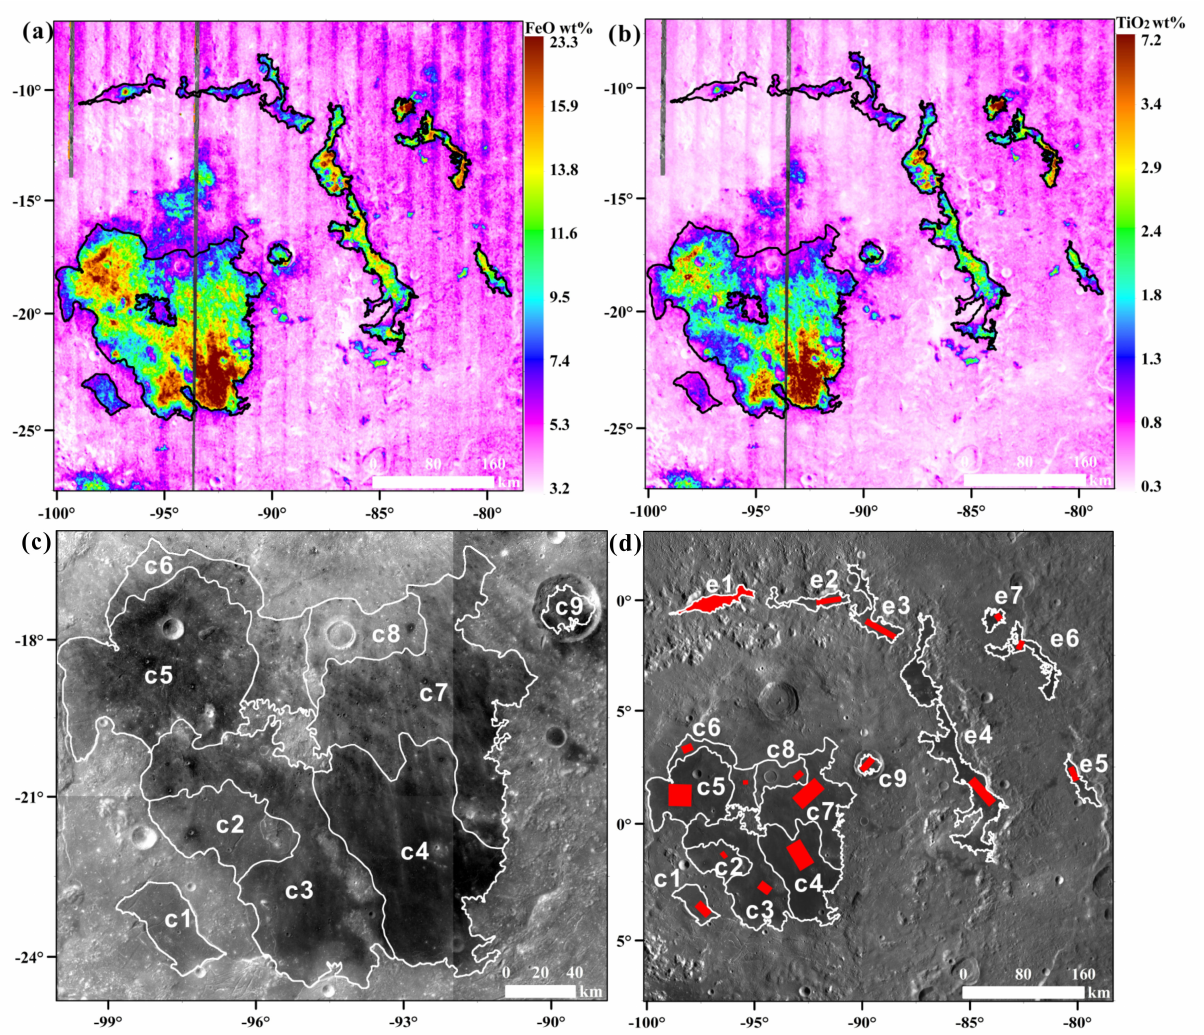
Figure 4. ( a ) IIM FeO abundance (wt%) map of the study area; ( b ) IIM TiO 2 abundance (wt%) map of the study area; ( c ) Newly defined geologic (basalt) units of the Orientale Basin. White lines denote the central basalts. As the background image is spliced from 7 CE-2 CCD images, there is a slight banding; ( d ) Basalts and crater counting areas of this study in WAC data. Red boxes denote the crater-counting